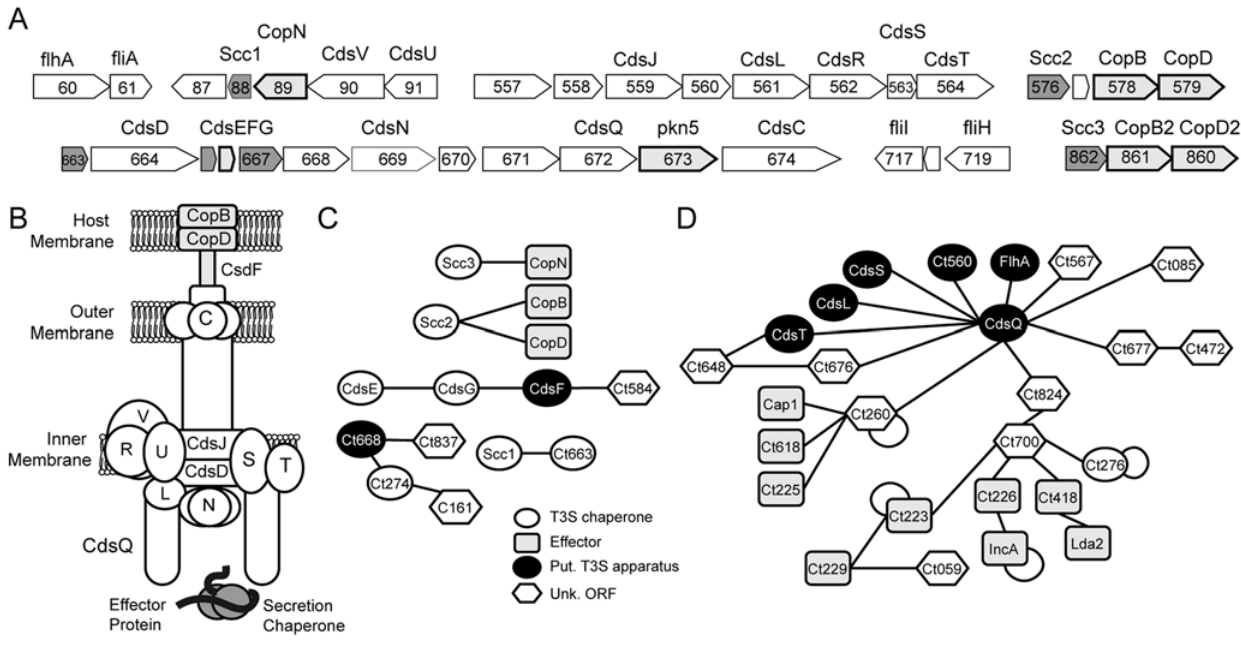
Figure 1. Yeast two-hybrid analysis defines hubs of protein-protein interactions linking the Chlamydia injectisome to secreted effectors. ( A ). Operon arrangement of conserved component of the C. trachomatis type III secretion system (T3SS) [16]. Light grey: secreted proteins, Dark grey: T3S chaperones ( B ). Proposed architecture of the Chlamydia injectisome . Assignments were made based on protein interactions conserved in other bacterial T3SS [6] and as proposed in [5]. Cds: contact dependent secretion protein, Cop: chlamydial outer protein. ( C ). Interactions between C. trachomatis T3S chaperones and their putative cargo . Protein-protein interactions were identified based on reciprocal YTH interactions. ( D ). Identification of interactions among core components of the C. trachomatis T3S apparatus, chlamydial proteins of unknown function and known effector proteins . Networks of putative interacting proteins were identified by Y2H analysis (Table S2). Self-interactions are denoted by arcs.